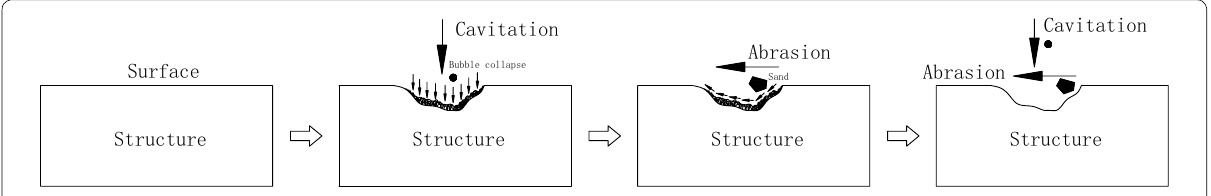
Fig. 14 Schematic of the mechanism of combined